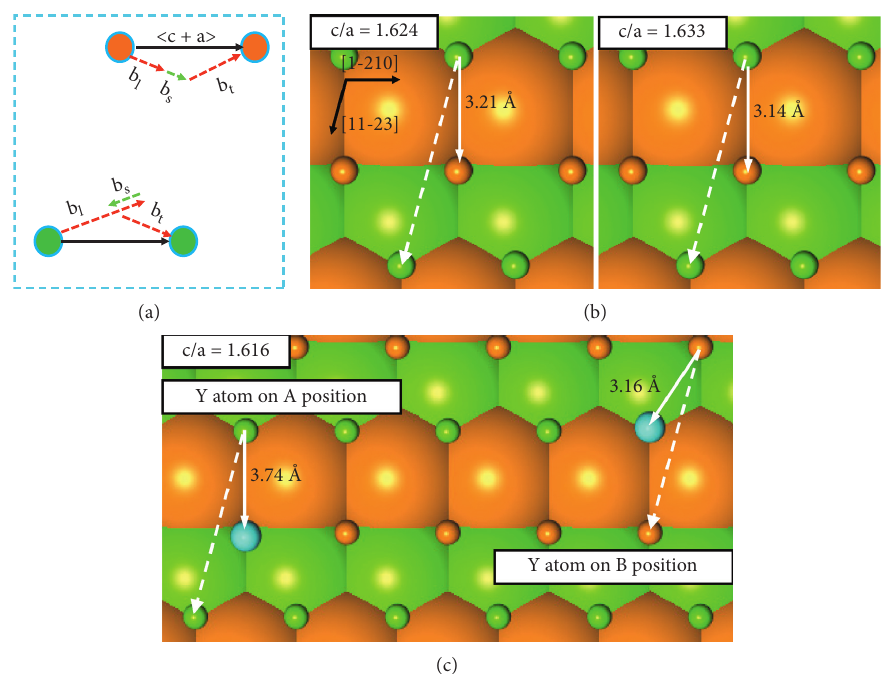
Figure 3: (a) Sliding pathway of 〈 c + a 〉 dislocation by the zigzag dissociation mode involved shuffling motion. The length of leading partial dislocations when the c / a ratio is equal to (b) 1.624 and 1.633. (c) The zigzag dissociation modes of Mg-Y alloy. Orange, green, and cyan spheres indicate type A Mg atoms, type BMg atoms, and Y atom,